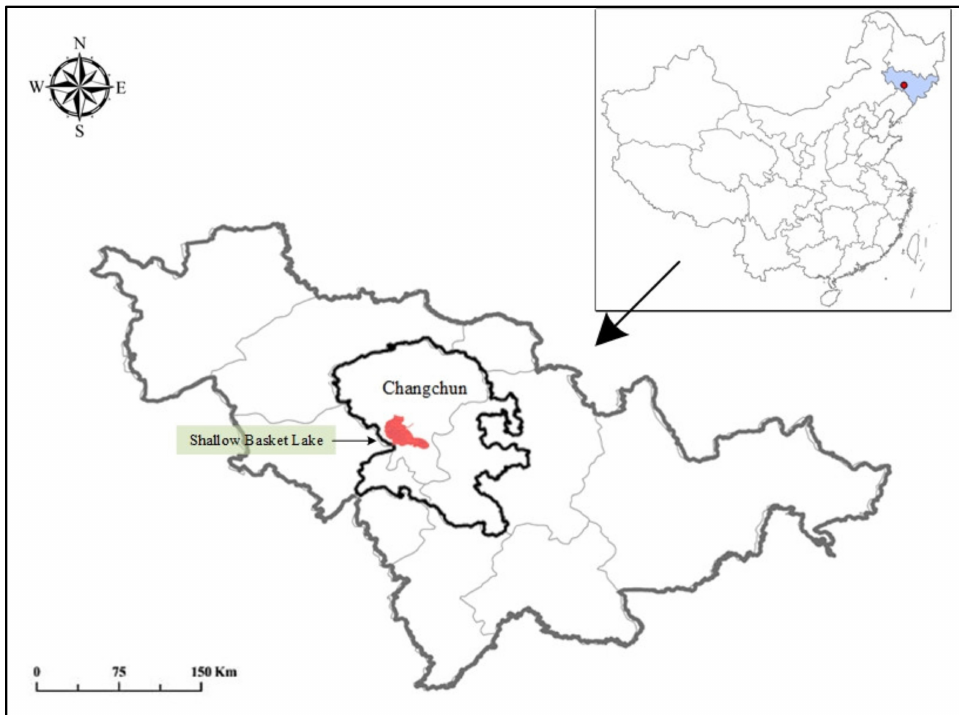
Figure 2. The geographic location of the study